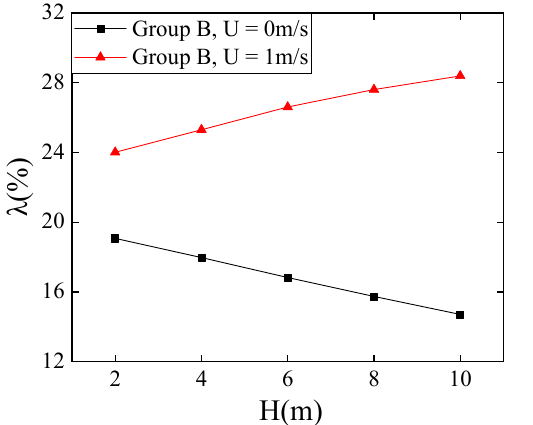
Figure 9. Surge suppression efficiency of the Serbuoys-TLP under different wave heights.